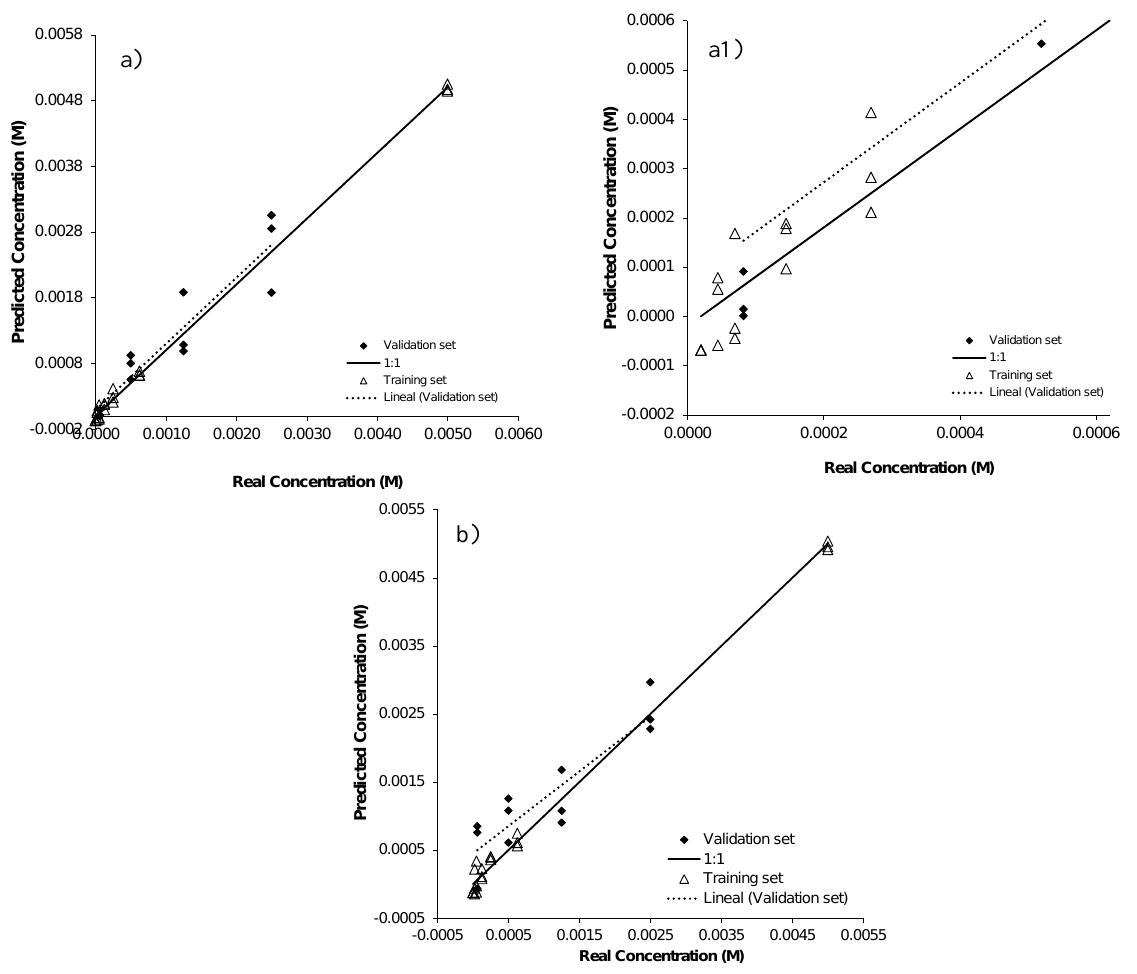
Figure 5. The results of the PLS prediction of glyphosate in phosphate buffer using ( a ) rotating electrodes, ( a1 ) an extension of graph (a) and ( b ) PLS prediction of glyphosate using static